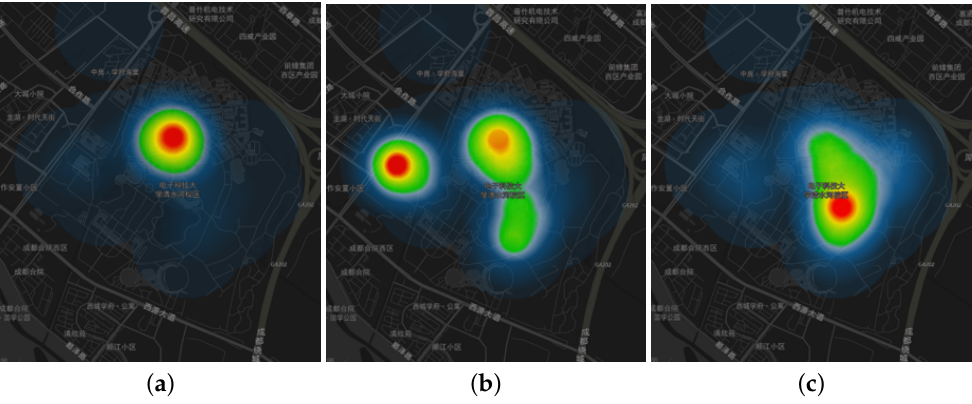
( a ) ( b ) ( c ) Figure 4. The heatmap of connected users in real-world campus scenarios: ( a ) 10:00 am on a weekday; ( b ) 1:00 pm on a weekday; ( c ) 5:00 pm on a weekend.